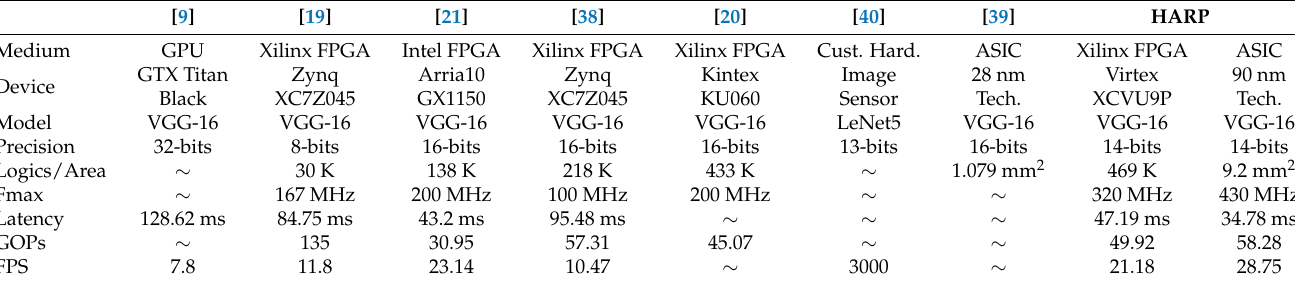
Table 6. Performance